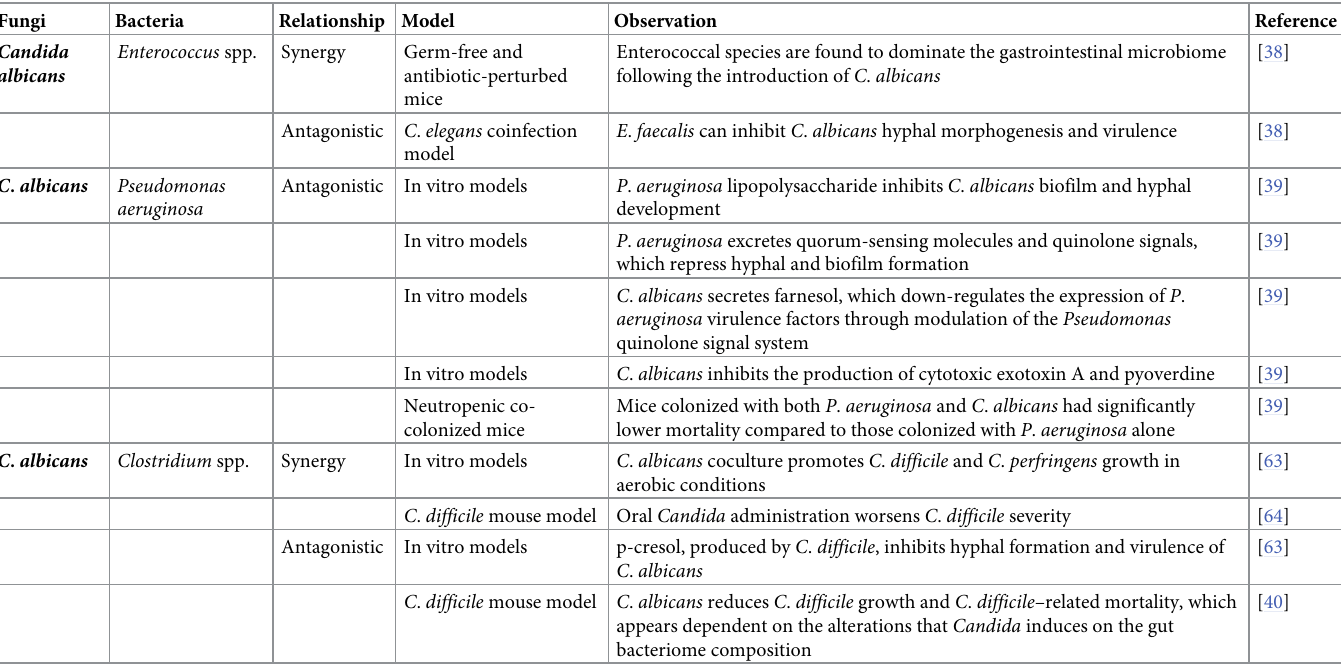
Table 1. Important fungal–bacterial interactions altering